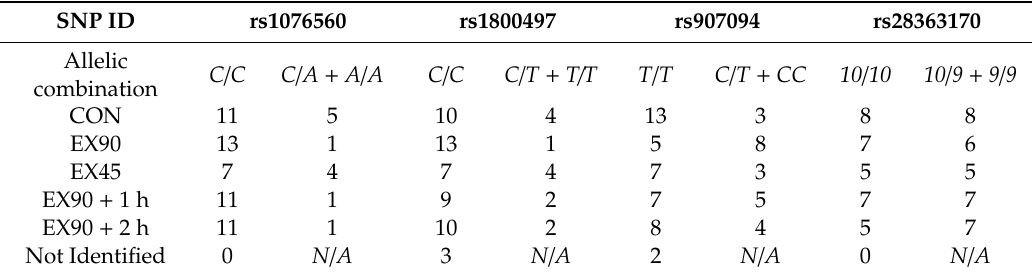
Table A3. Allele distribution across participants in the di ff erent intervention